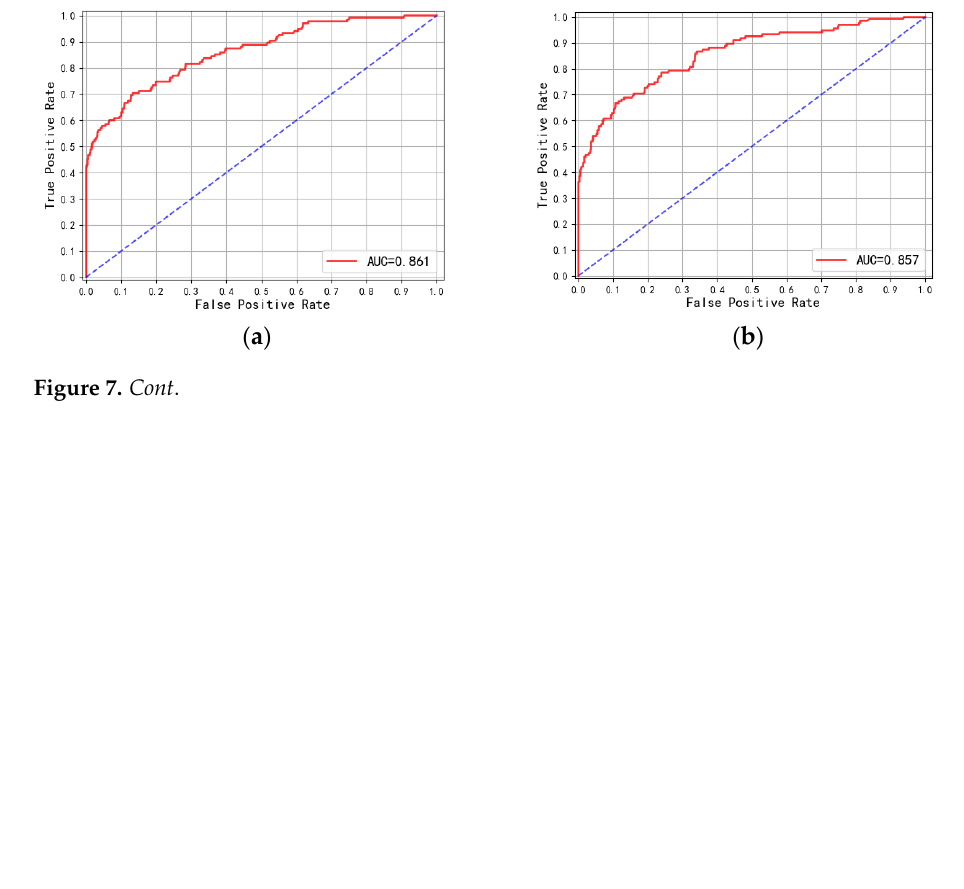
Figure 6. Importance of model feature: ( a ) gaze — random forest; ( b ) secondary driving task — ran- dom forest; ( c ) gaze — AdaBoost; ( d ) secondary driving task — AdaBoost; ( e ) gaze — XGBoost; ( f ) sec- ondary driving task —